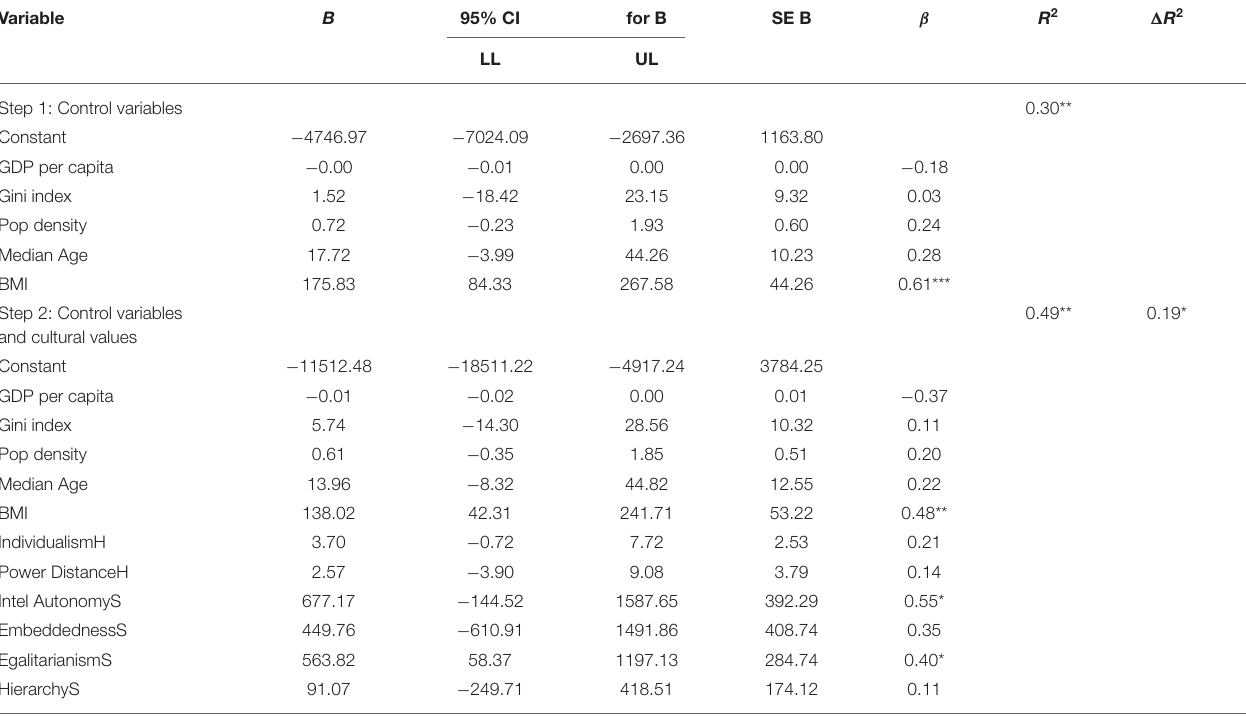
TABLE 5 | Hierarchical regression results for COVID-19 deaths per 1 million on December 29, 2020 (WHO).